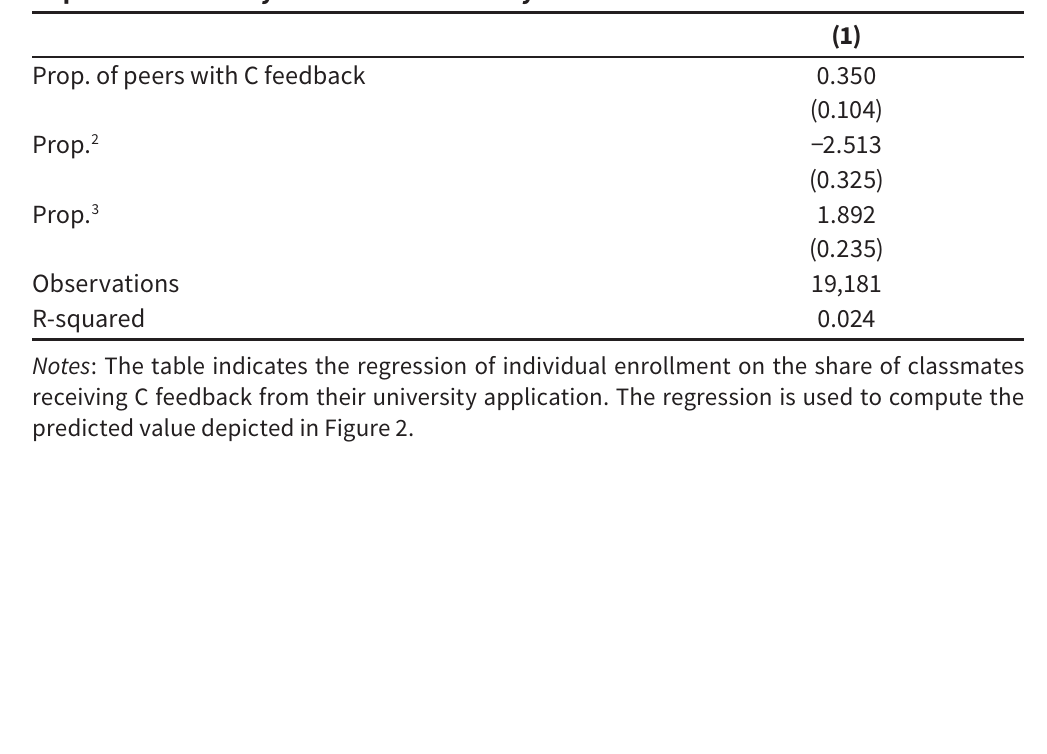
Regression of individual enrollment on the share of peers with a C feedback Dep. Var: Probability to Enroll at